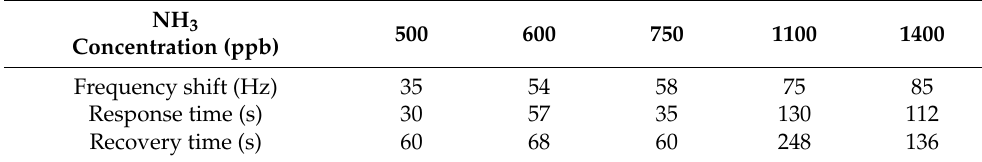
Table 1. Sensing performance of the SAW sensor toward NH 3 gas in dry air. NH 3 Concentration (ppb)